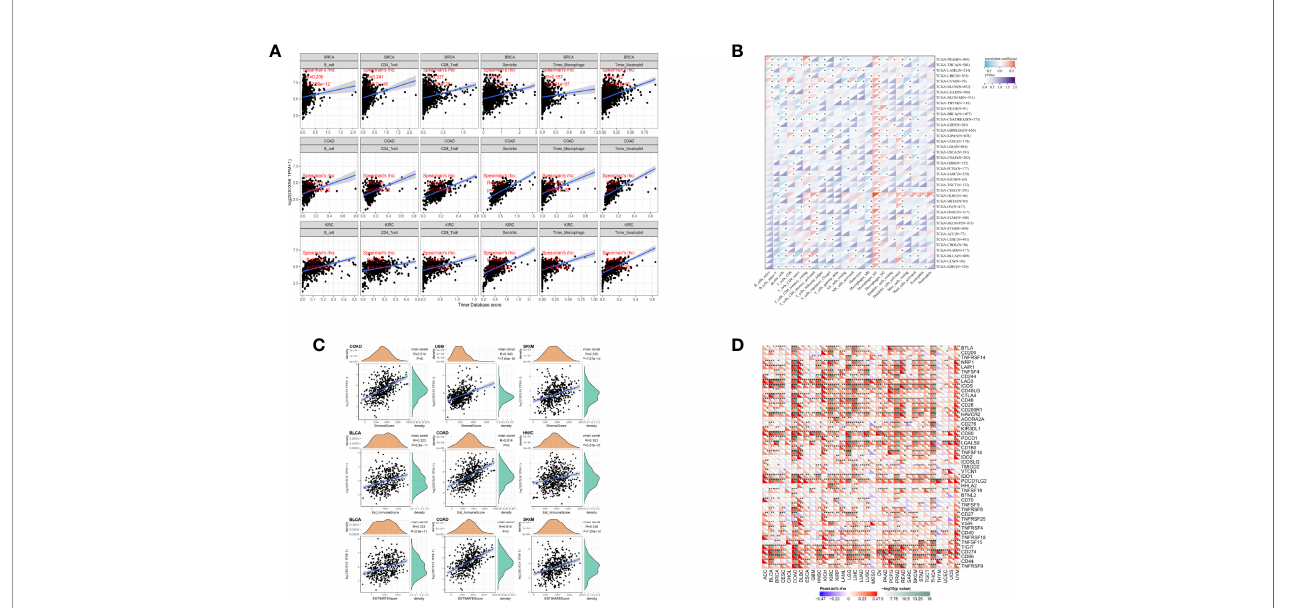
FIGURE 9 | Correlation between DDX58 expression levels and cancer immune in fi ltration (A) Relationship between DDX58 expression levels and immune in fi ltration in the three most signi fi cantly associated tumors; (B) Heat map of the relationship between 22 immune cells and DDX58 in 33 tumors using CIBERSORT analysis; (C) Relationship between DDX58 expression levels and immune score, stromal score and ESTIMATE score in the three most signi fi cantly associated tumor types, respectively. (D) Correlation of DDX58 expression levels with immune checkpoint gene expression. * P < 0.05, ** P < 0.01, *** P <